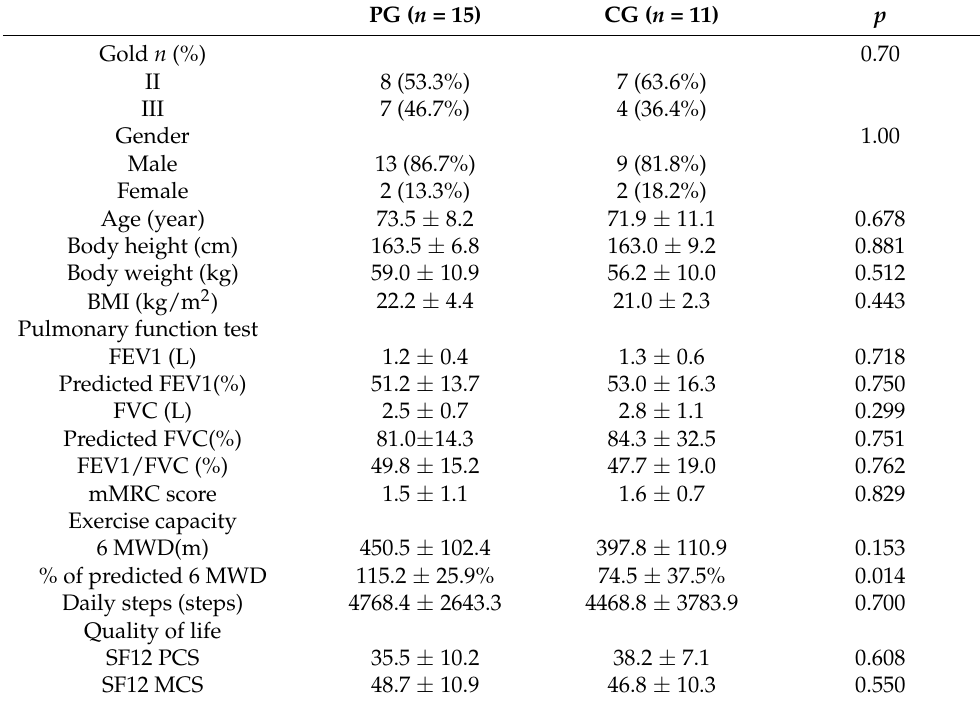
Table 1. Demographic data of subjects in pedometer (PG) and control group (CG).